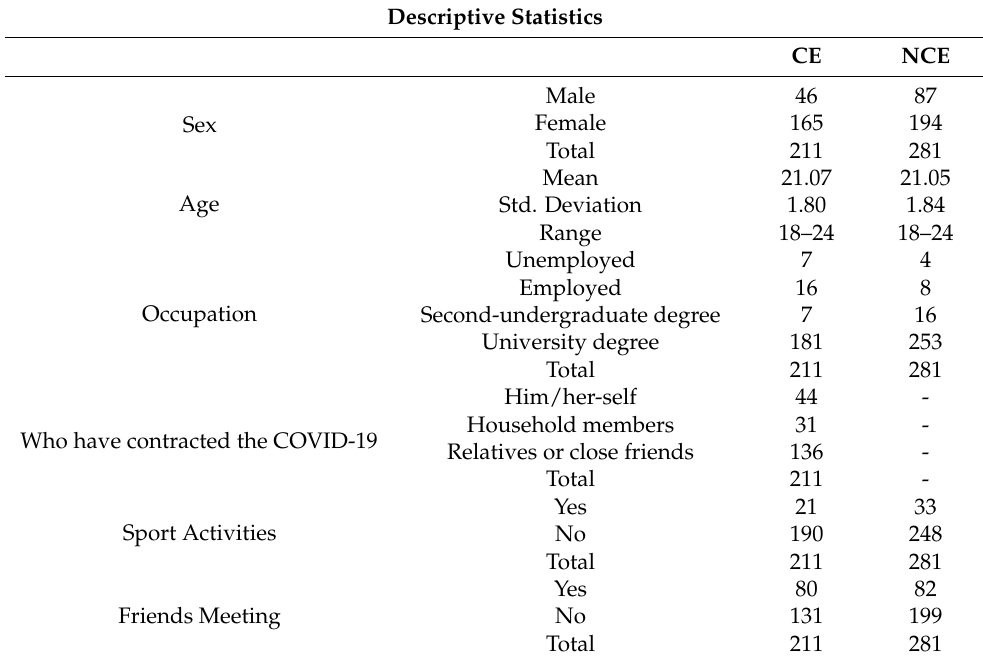
Table 1. Demographic characteristics of the studied